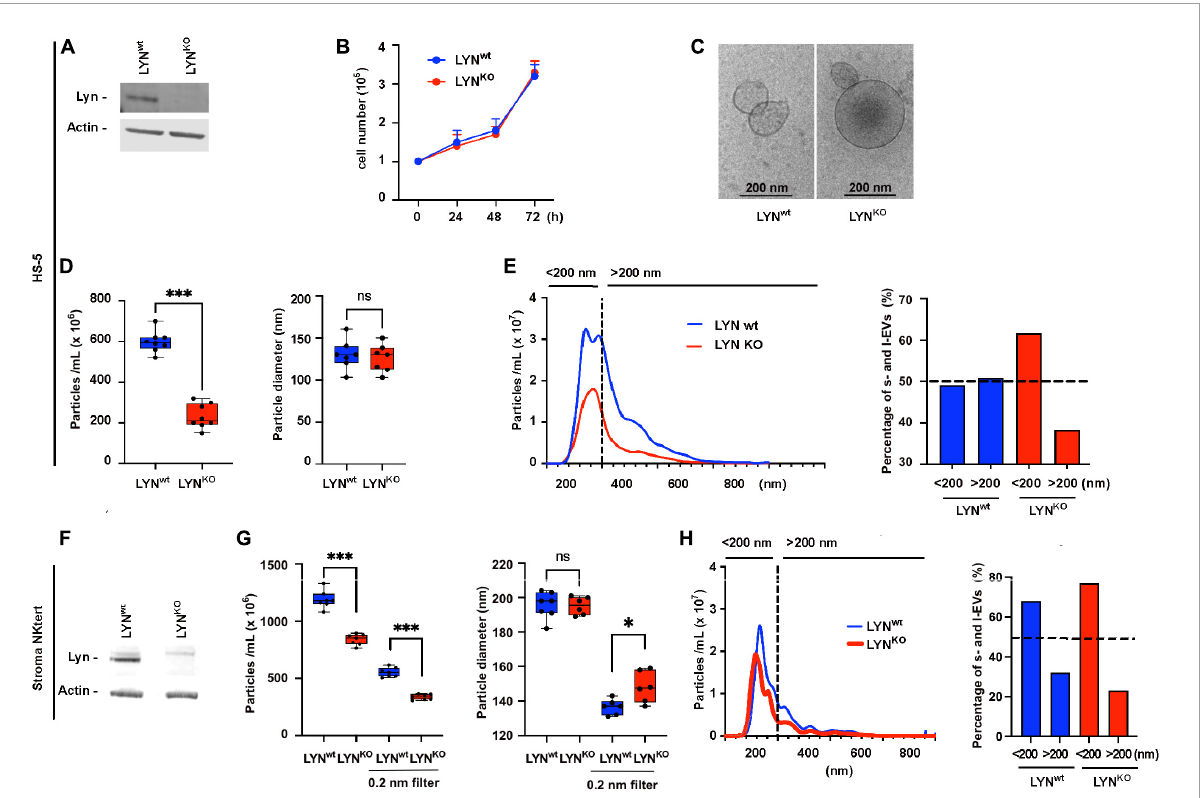
FIGURE2 Influence of Lyn on the extracellular vesicles (EV) release in stromal cells. HS-5 cells (wt) and Lyn-deficient counterparts (KO) were compared. (A) The expression of Lyn was determined in both cell types by western blot. (B) The growth conditions were tested in a kinetic study by determination of the cell count at time points as indicated. (C) The EVs in the cell-free supernatants were isolated by sedimentation for 90 min at 110,000 × g and visualized by cryo-transmission electron microscopy (TEM). (D) To compare the EV concentration both HS-5 cell types were cultivated for 24 h in medium with EV-depleted serum. After precentrifugation steps at 300 × g , 3,000 × g, and 10,000 × g , the EVs were sedimented at 110,000 × g , suspended in 500 µ L PBS and purified by size exclusion chromatography (SEC). Then, the EV count and diameter of the suspension was determined by nanoparticle tracking analysis. (E) To plot which EV size is predominantly influenced by Lyn in HS-5 cells, the EV diameter and count are shown in a histogram. A dashed line separates particles ≤ 200 nm (s-EVs) and ≥ 200 nm (l-EVs). The percentage of particles < 200 nm and > 200 nm is calculated and depicted in a bar chart. The influence of Lyn on the EV release was also tested in the supernatant of wt and Lyn-defective StromaNKtert cells, another stromal cell line. (F) The expression of Lyn was determined in both StromaNKtert types by western blot. (G) The particle count and diameter were determined by nanoparticle tracking analysis. This time, the EVs were not purified by SEC but aliquots were filtered through a 200 nm filter. (H) To plot which EV size is predominantly influenced by Lyn in HS-5 cells, the EV diameter and count are shown in a histogram. A dashed line separates particles ≤ 200 nm (s-EVs) and ≥ 200 nm (l-EVs). The percentage of particles < 200 nm and > 200 nm is calculated and depicted in a bar chart. The results were statistically evaluated by a two-tailed, non-parametric t -test (Mann–Whitney) (ns = not significant, ∗ P < 0.05, ∗∗∗ P <